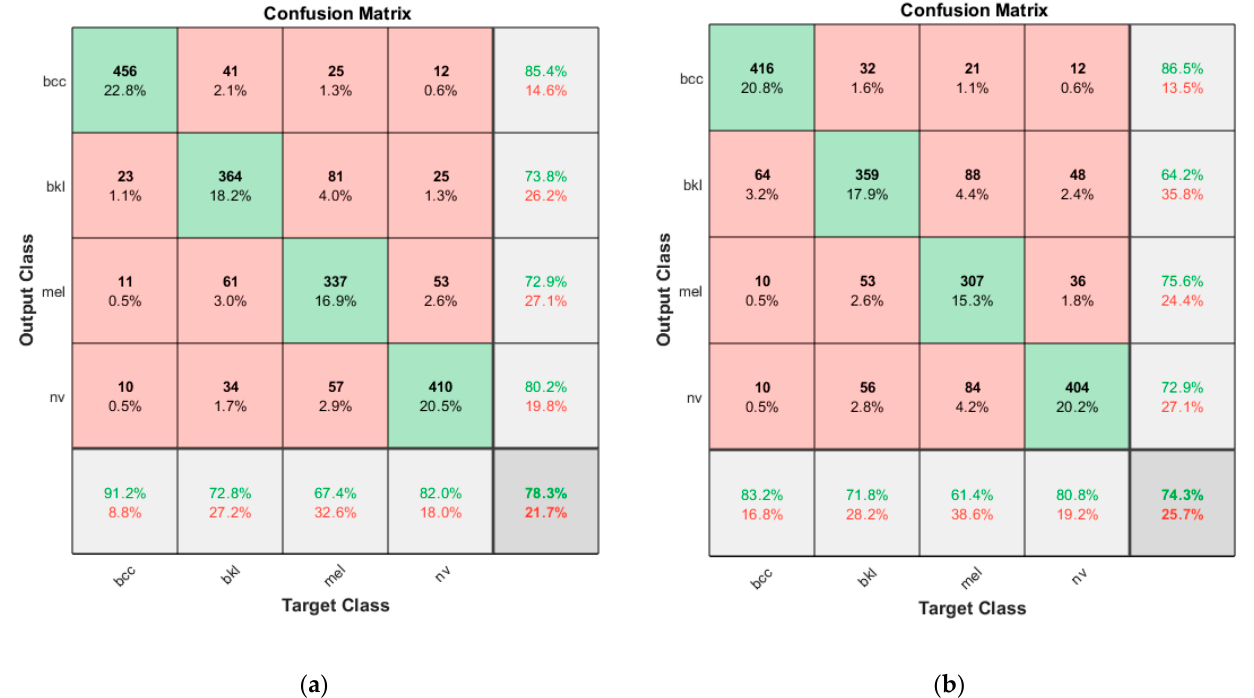
Figure 6. ( a ) Confusion matrix of Model IV without data augmentation; ( b ) confusion matrix of Model IV using combined data augmentation.